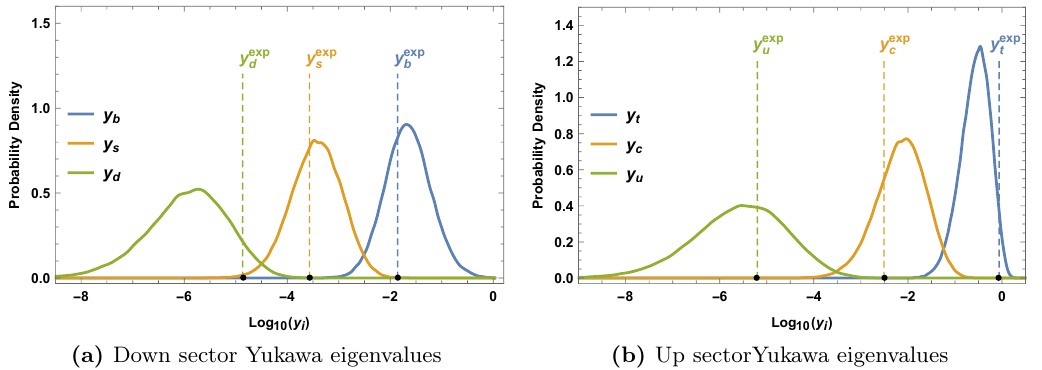
Figure 5. Quark Yukawa eigenvalues distributions for N q = 5, N u = 7, N d = 2, (cid:24) q = 1 : 8, (cid:24) u = 1 and (cid:24) d =